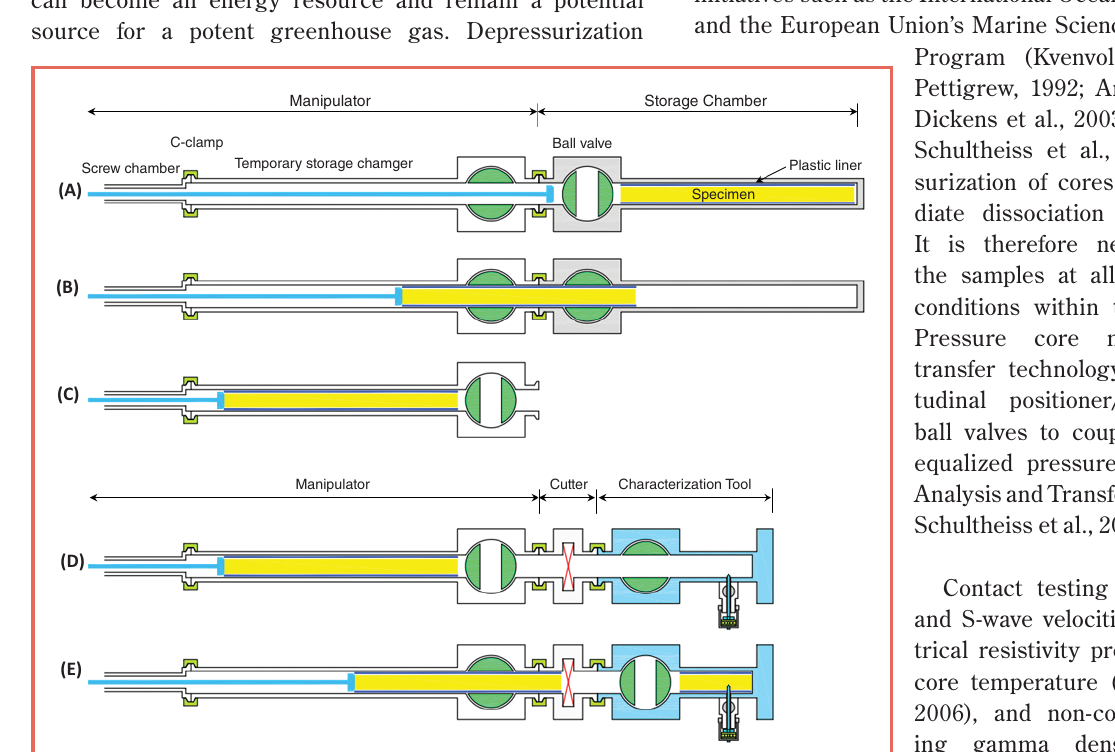
Figure 1. Pressure core manipulation. [A] The manipulator (MAN) couples with the storage chamber, and fluid pressures are equalized at the target pressure p0 before opening the ball valve. [B] The MAN captures the core and transfers it to the temporary storage chamber. [C] Ball valves are closed, and the depressurized storage chamber is separated. [D] The selected characterization tool is coupled to the MAN and is pressurized to p 0. [E] Ball valves are opened, and the core is pushed into the characterization tool; stand-alone characterization tools may be detached after retrieving the rest of the core and closing valves. Note: the cutter tool (CUT) is shown in panes [D] & [E]; it is attached in series to cut core to any desired length to meet tool requirements (for stand-alone ESC, DSC, CDC, and BIO